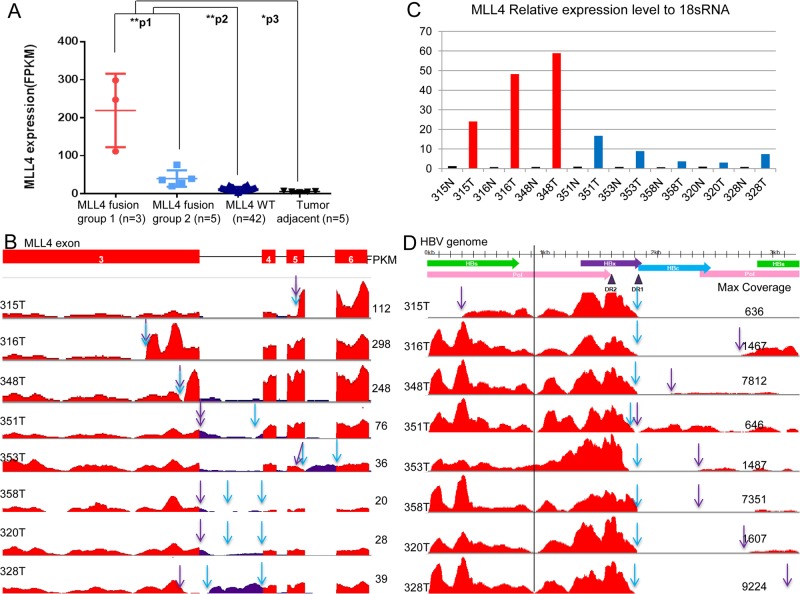
HBV transcripts and MLL4 mRNA expression.(A) MLL4 mRNA expression (FPKM value) comparison across four groups: the MLL4 fusion group 1 represents HCC samples carrying HBV integration into MLL4 exon 3 or 5; the MLL4 fusion group 2 represents HCC samples with the HBV integration into MLL4 introns or intron/exon boundaries; the MLL4 WT group represent HCC samples with MLL4 integration wild-type; and the tumor-adjacent represents HCC-adjacent normal samples. The p-values were determined by an unpaired one-tailed t-test, **p1 = 0.003, **p2 = 1.57E-7, *p3 = 0.03. (B) MLL4 exon 3 to exon 6 coverage by RNA sequencing. HBV-MLL4 integration upstream junction sites are shown with purple arrows and downstream junction sites with blue arrows. The MLL4 gene expression level was quantified as the FPKM value for each sample, as shown on the right.